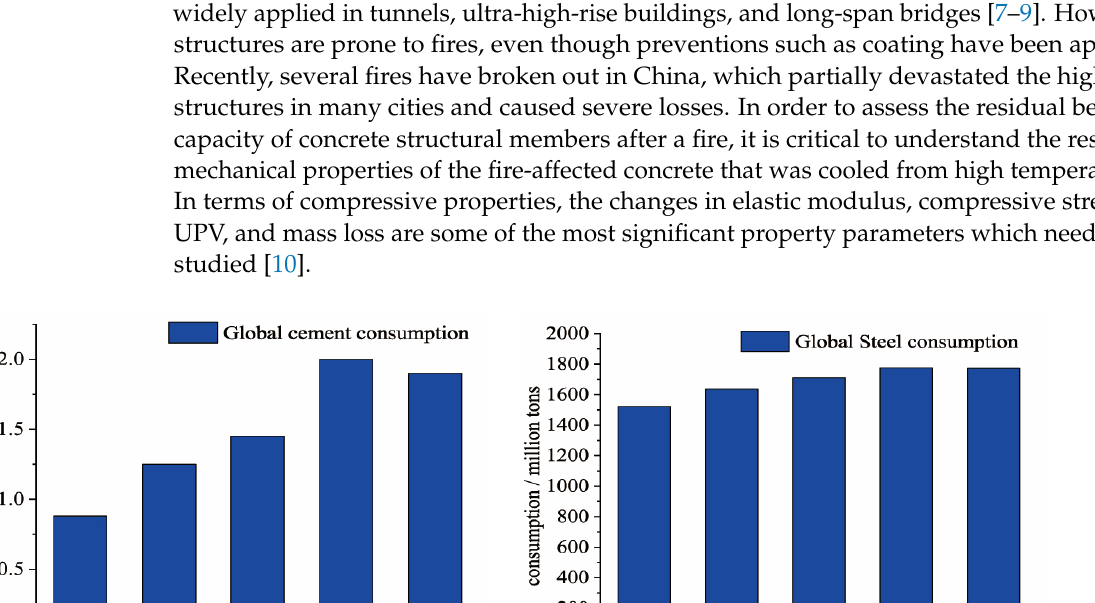
Table 1. Components and corresponding proportions of the SCC specimens (kg/m 3 ).